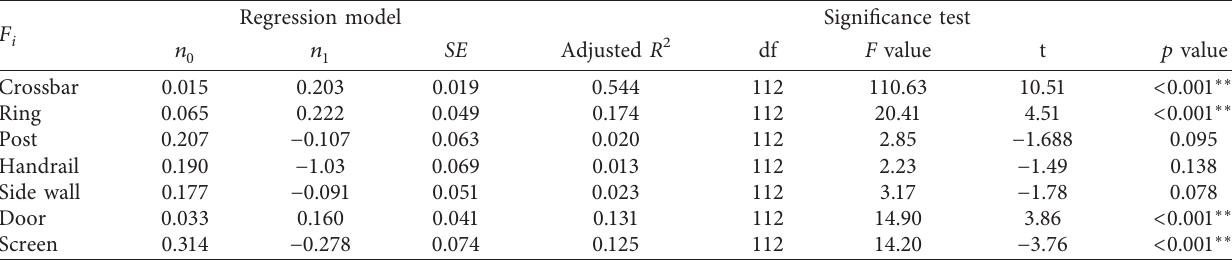
Table 7: Explanatory model of the proportion of facilities in